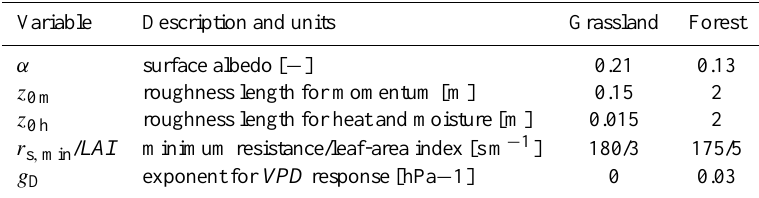
Table 1. Model parameters specific for forest and grassland. Values taken from the ECMWF IFS documentation (Cy36r1, Table 8.1) using the mixed crops as the value for grassland and the broadleaf deciduous forest for